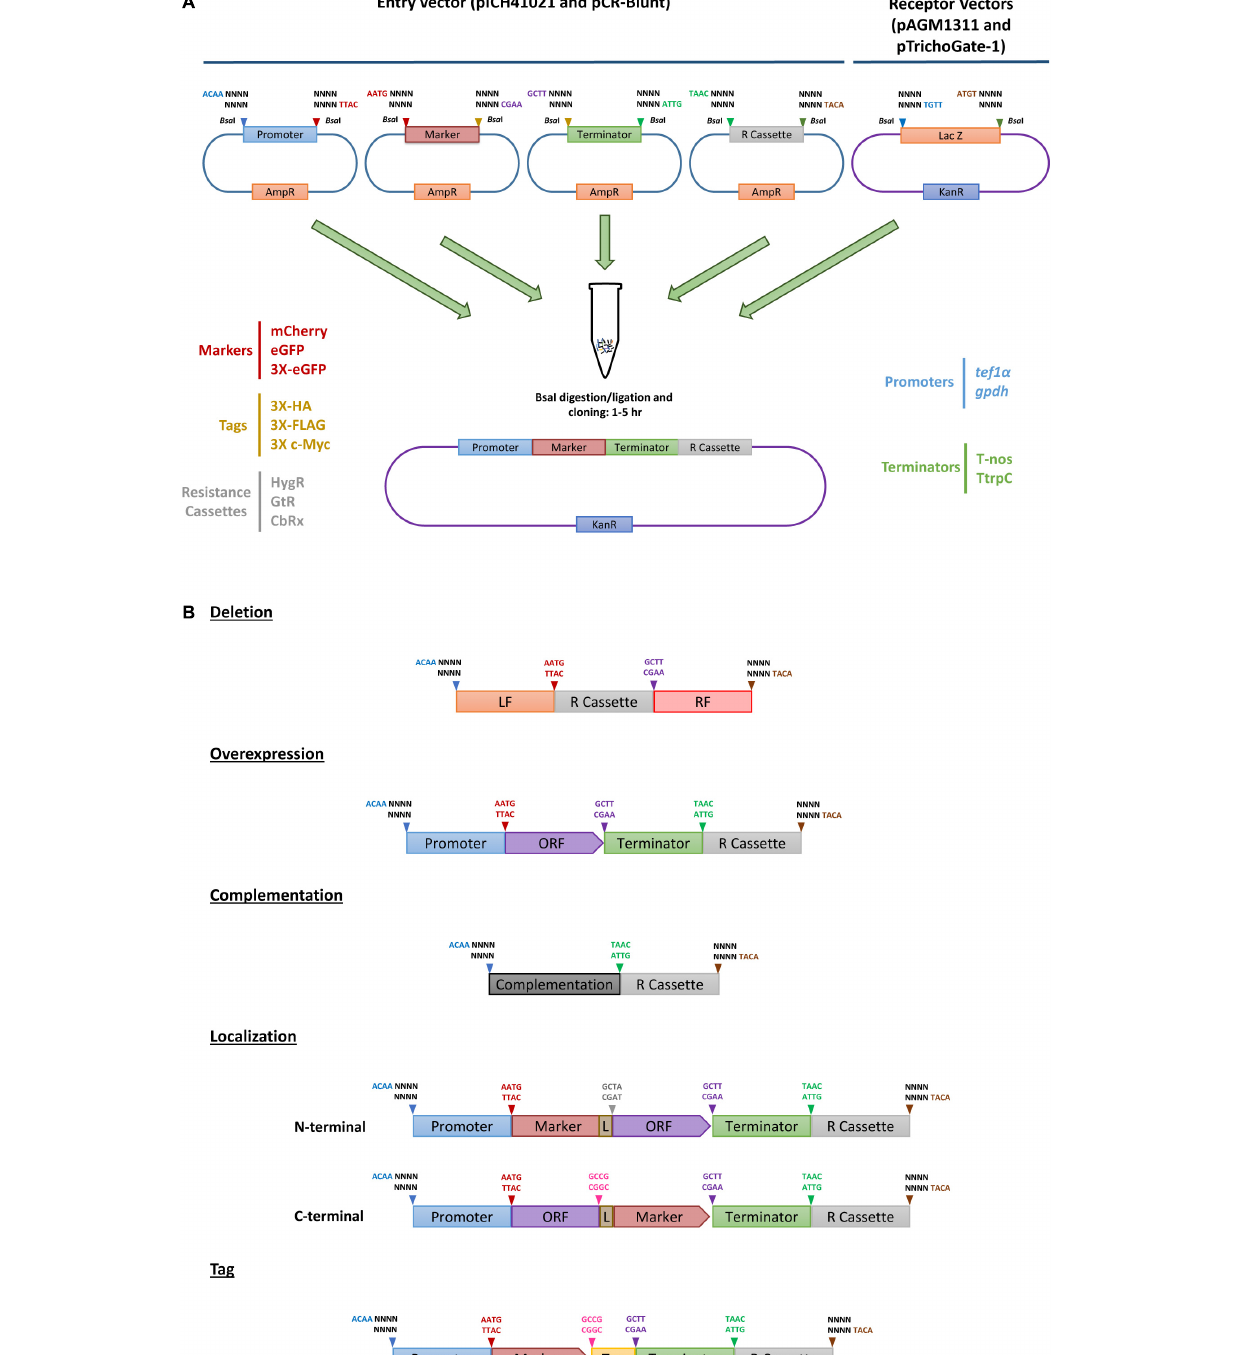
Frontiers in Microbiology |